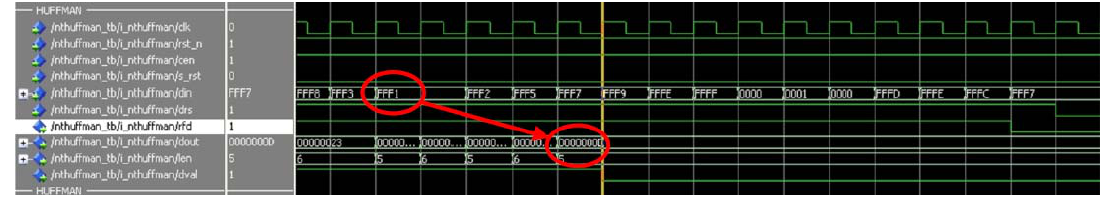
Figure 6. Compression module Input/Output block timing. End of block.